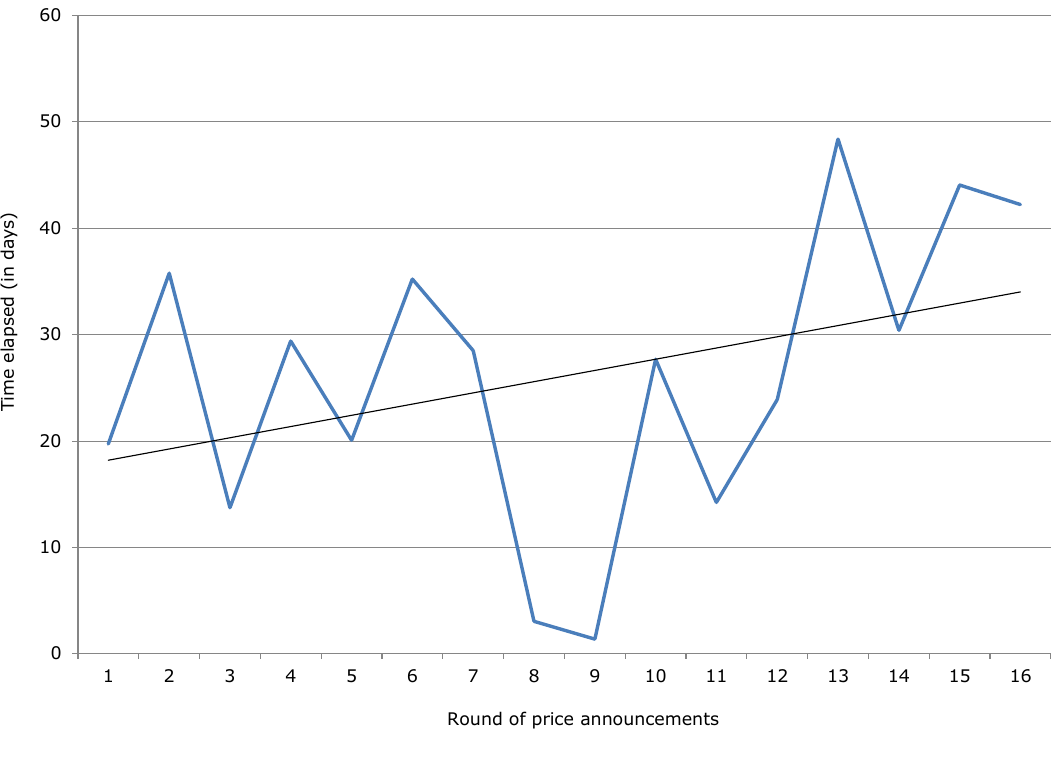
Figure 34: Average time (in days) elapsed between announcement date and ‘effective by’ date